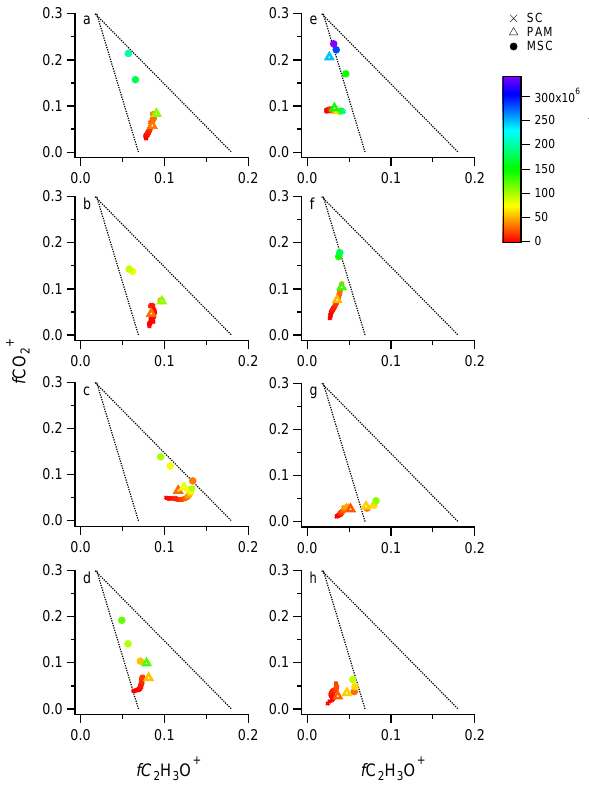
Figure 7. Plot of f CO + as a function of f C 2 H 3 O + for SOA gen- 2 erated during each wood-burning experiment ( a–h , experiments 5– 12, respectively). Data points correspond to the SC and the PAM and MSC when sampling from the SC.